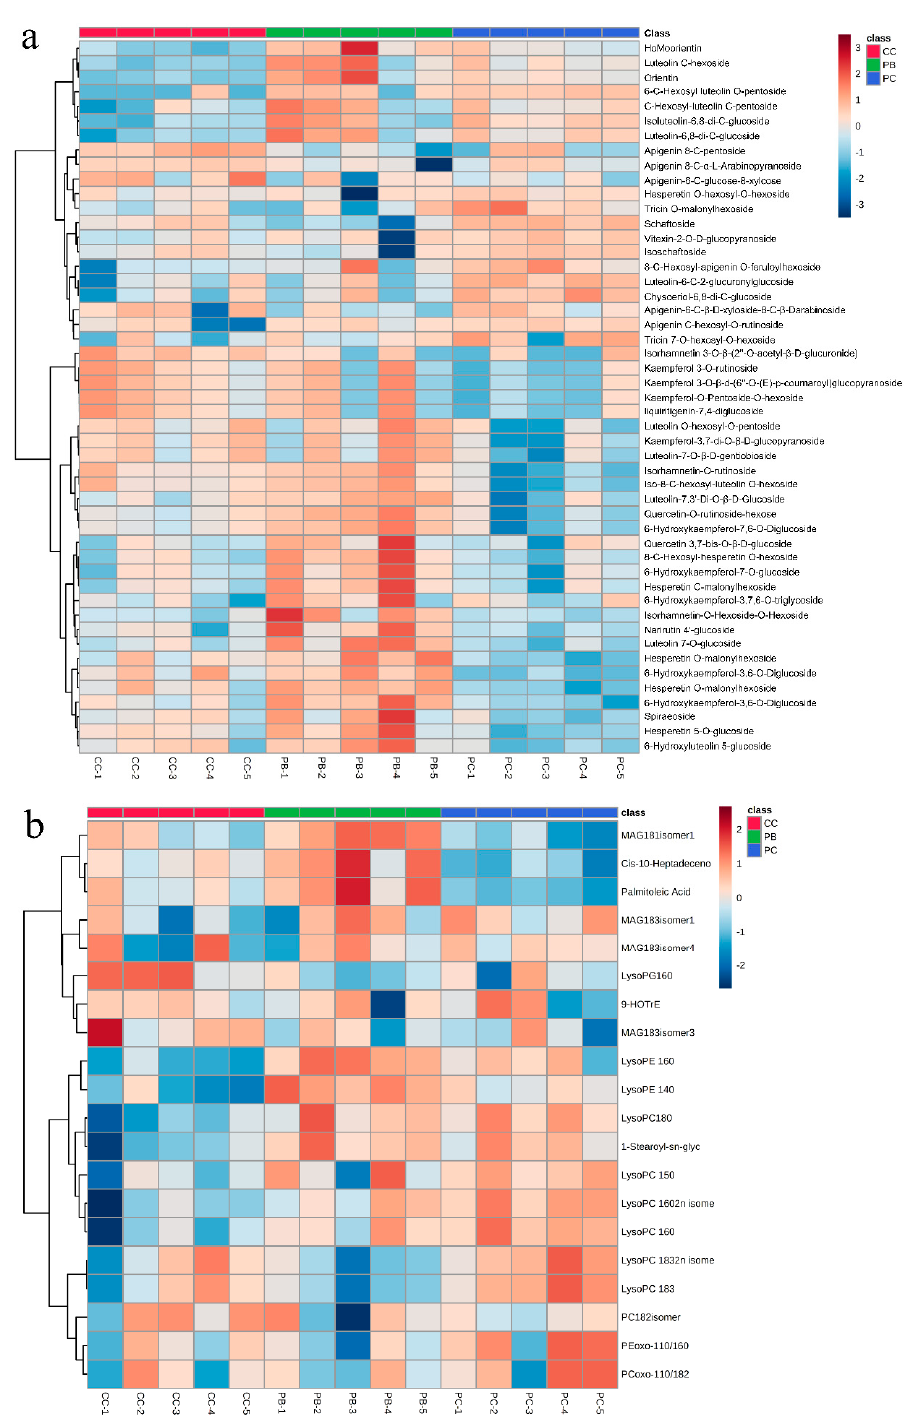
Figure 5. Heatmaps of hierarchical cluster analysis (HCA): ( a ) flavonoids; ( b ): lipids. The abscissa is used to display the names of samples, and the ordinate on the right is used to display the names of metabolites. The deeper the red color, the higher the content of the metabolites; the deeper the blue color, the lower the content of the metabolites.